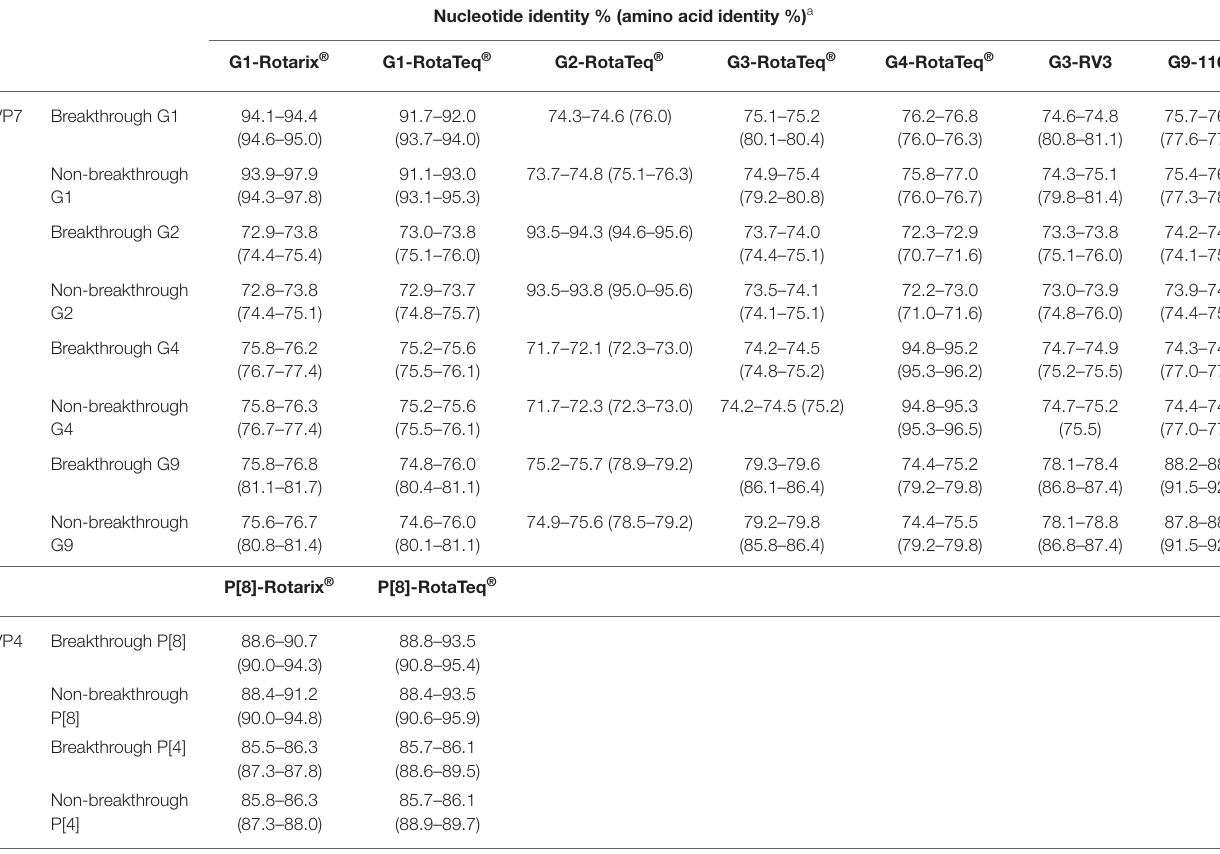
TABLE 2 | Distance matrix for VP7 and VP4 based on nucleotide and amino acid